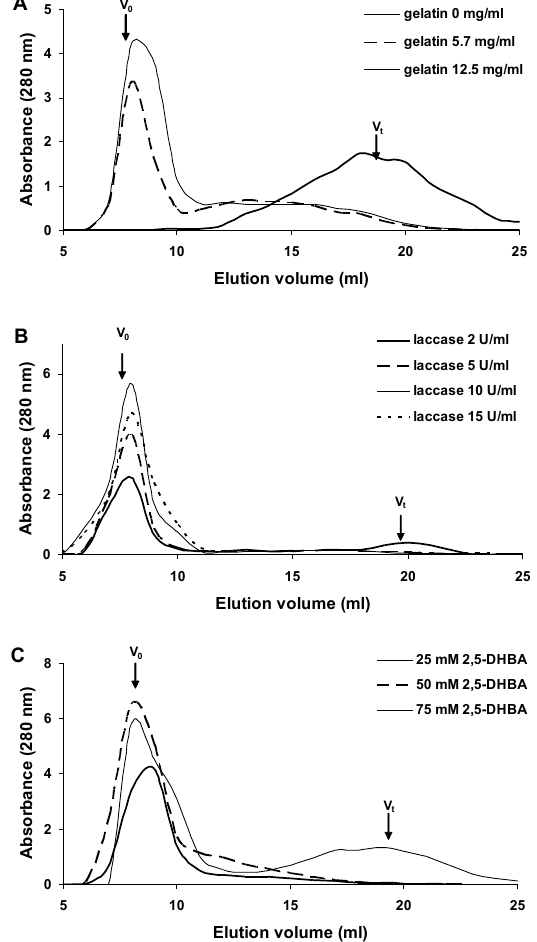
Figure 1. Optimization of the synthesis of the 2,5-DHBA–gelatin conjugate. Concentrations of the reactants: ( A ) gelatin—0–12.5 mg/mL, laccase—5 U/mL, 2,5-DHBA—50 mM; ( B ) laccase—2–15 U/mL, gelatin—12.5 mg/mL, 2,5-DHBA—50 mM; ( C ) 2,5-DHBA—25–75 mM, gelatin—12.5 mg/mL, laccase—10 U/mL. The data of gel filtration chromatography on Sephadex G-75 are presented. The arrows indicate the void volume ( V o ) and the total column volume ( V t ).